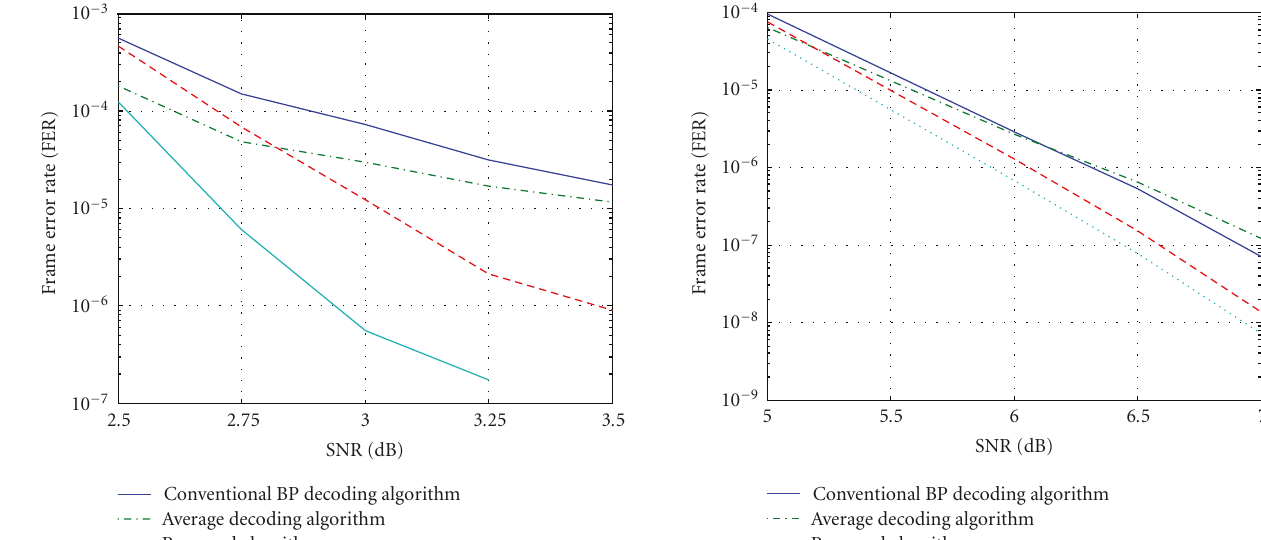
Proposed algorithm Proposed algorithm on top of average decoding Figure 9: Performance results for PEG(100,50) LDPC code.